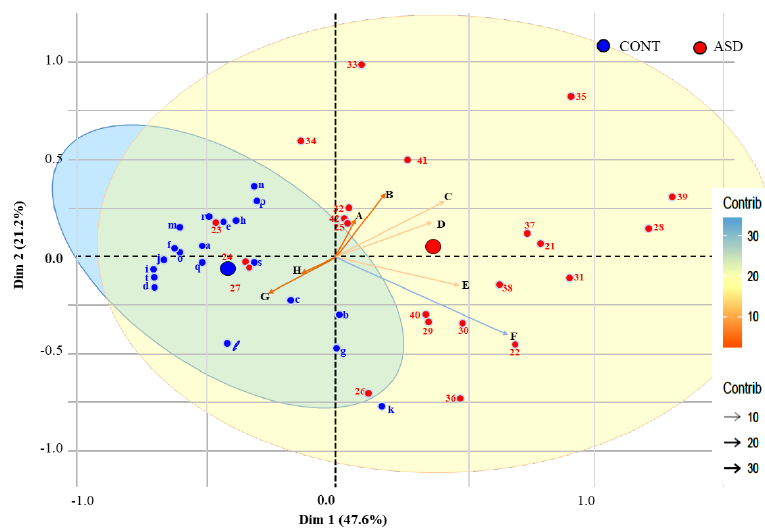
Figure 2. Principal component analysis (PCA) biplot. A: tandem walking backward; B: walks on side of feet; C: ball skills (item E); D: ball skills (item D); E: dexterity (item B) F: dexterity (item C); G: EUROFIT sit up test; H: VO 2 ; Contrib = contribution; Dim: dimension. Children are represented from a to t for the CONT group ( n = 20) and 21 to 42 for children with ASD ( n = 22). Two clusters were determined with the blue space representing the CONT group and the yellow space representing children with ASD. Four children with ASD [23,24,26,27] were misclassified and their scores appeared in the CONT group (blue cluster), and one CONT child (k) was classified outside of this cluster.